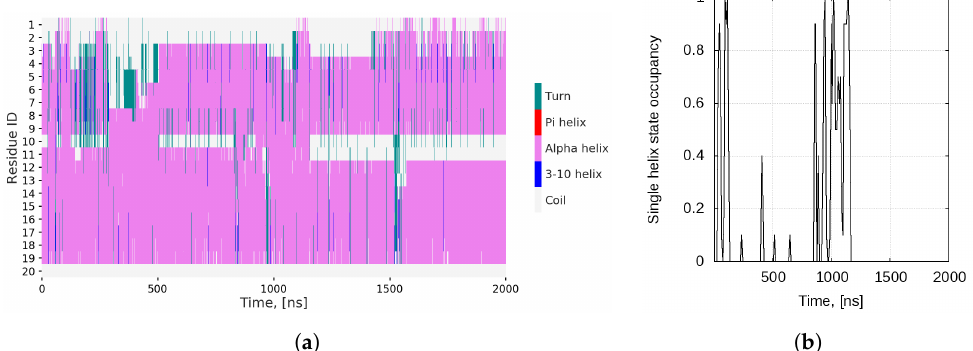
Figure 2. ( a ) Secondary structure; and ( b ) occupancy of the single α -helix conformational state, averaged over 10 ns windows, of monomeric bombinin H2 in